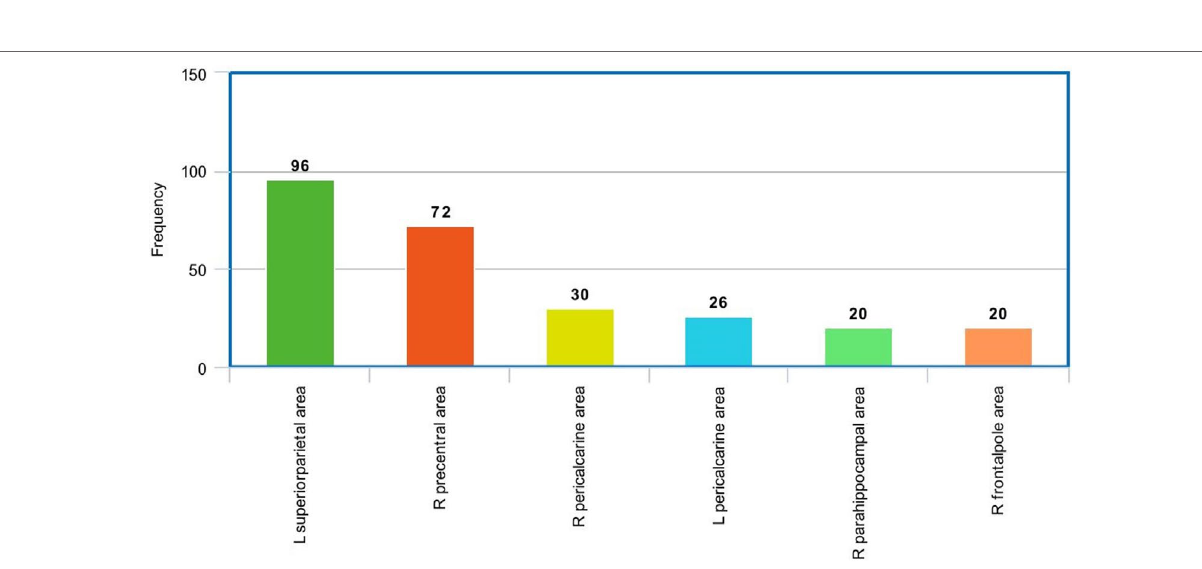
FIGURE 9 | The most frequent areas in the sMRI experiment found to be associated with significantly correlated features with ADOS overall